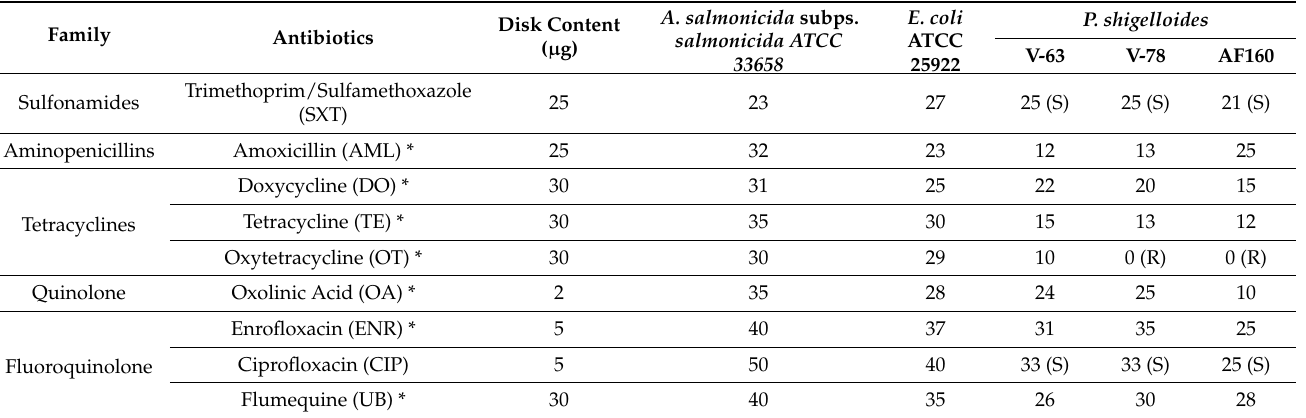
Table 4. The inhibition zones (mm) of antimicrobial agents for quality control and P. shigelloides